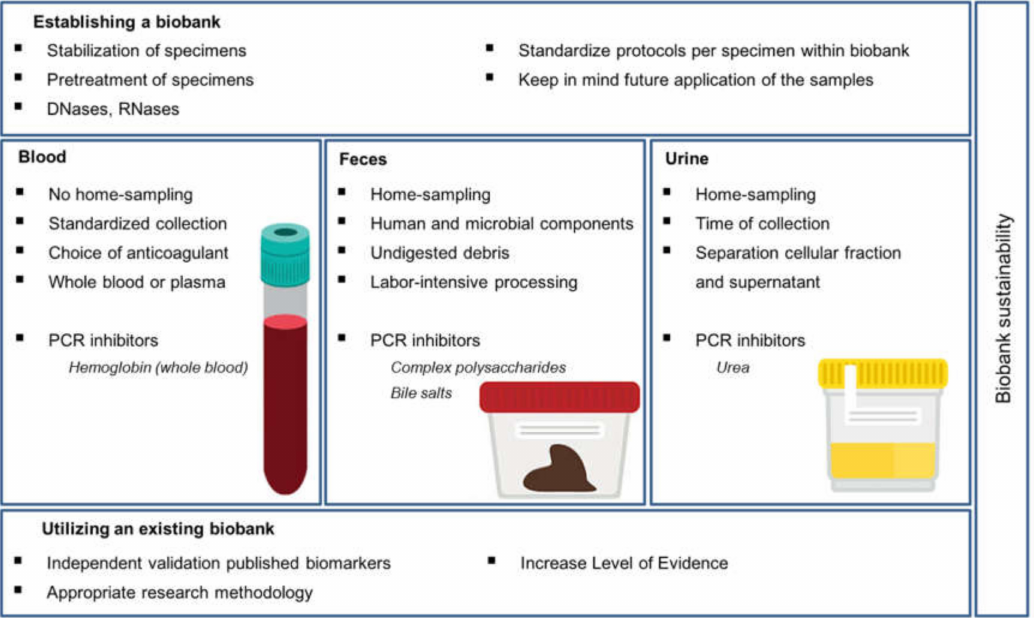
Figure 1. Summary of crucial considerations for establishing a biobank, handling of specific sample types and using existing